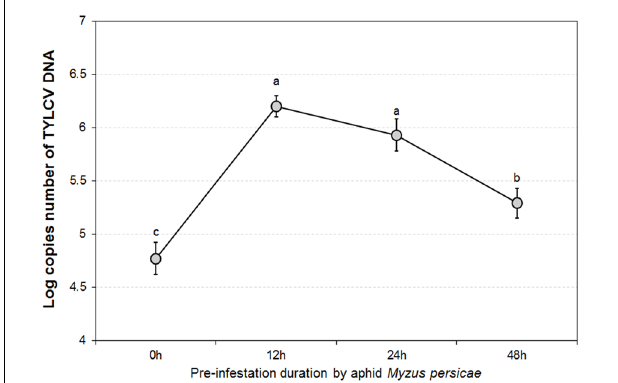
FIGURE 3 | TYLCV DNA concentrations in Bemisia tabaci adults after feeding on TYLCV-infested tomato plants for 24 h according to various Myzus persicae pre-infestation. The error bars are standard errors of the mean. Letters indicate significant differences of DNA concentration among different aphid pre-infestation durations according to Duncan’s test at P =